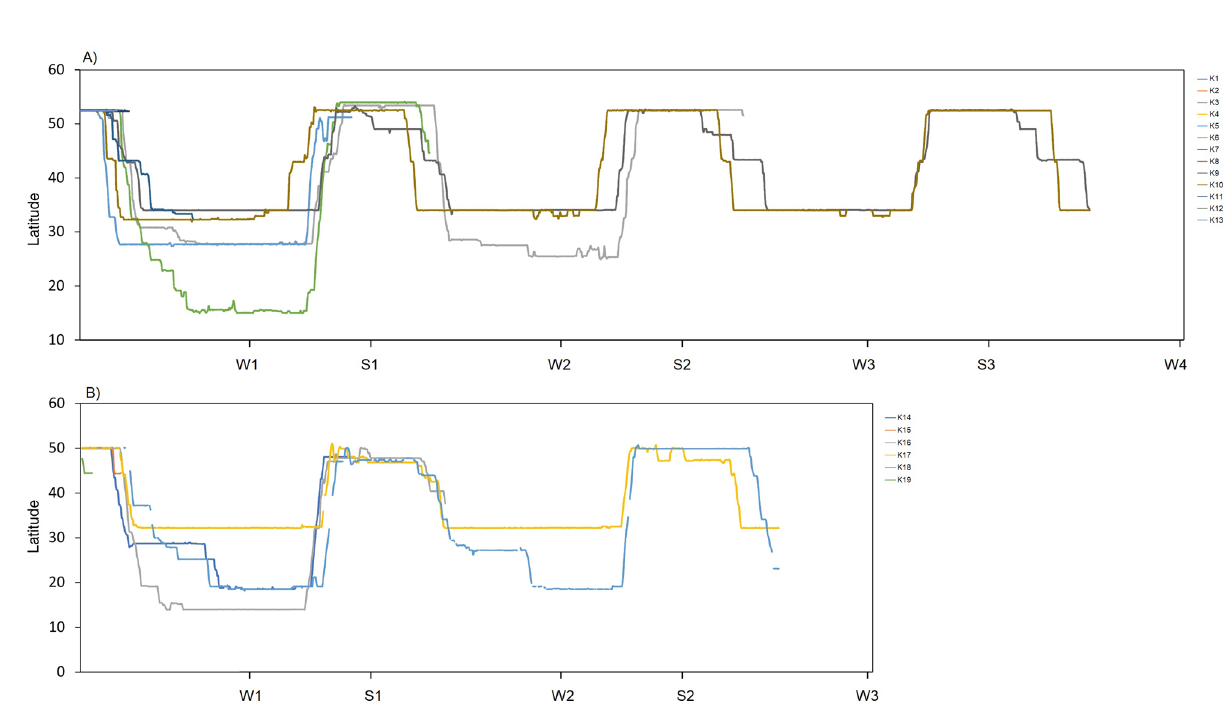
Figure 2. Latitudinal occurrences of tracked Black Kites throughout their lifespan. W1, W2 and W3 refer to the location of birds on 31 January in 2cy, 3cy and 4cy, respectively; S1, S2 and S3 refer to the location of birds on 30 June in 2cy, 3cy and 4cy, respectively. ( A ) Black Kites from Biysk (lowland in southwestern Siberia); ( B ) Black Kites from Kosh-Agach (Upper